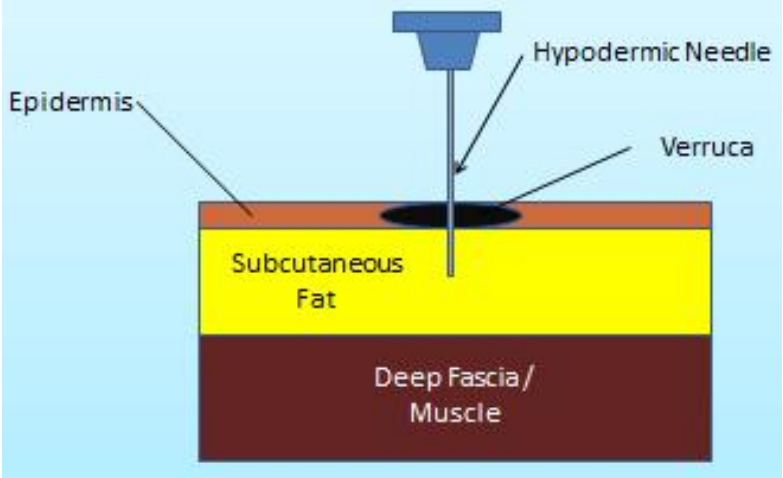
Figure 1. Demonstrating the needling